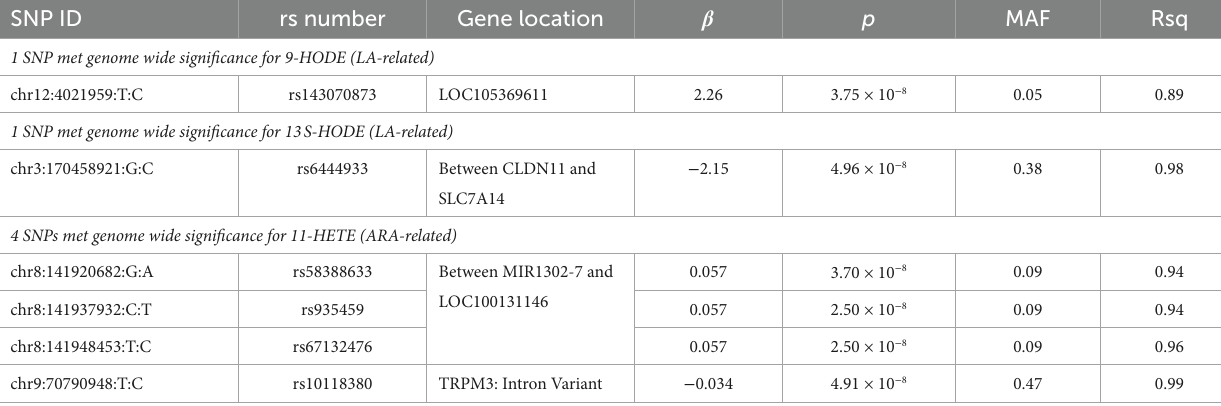
TABLE 3 Genome-wide significant SNPs associated with individual oxylipins. SNP